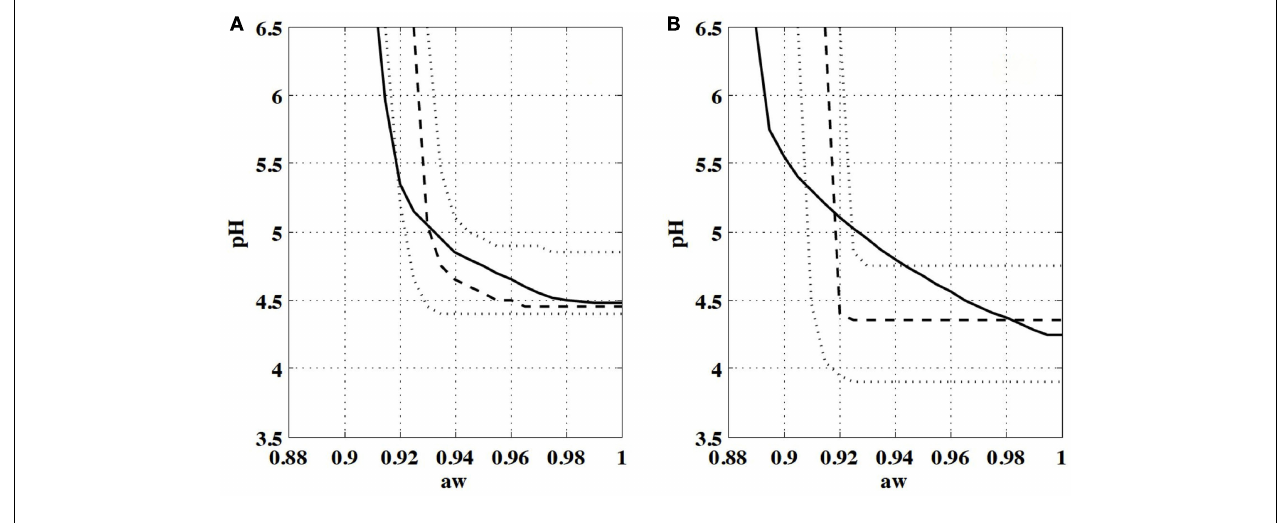
Koutsoumanis and Sofos (2005) for a growth probability of 0.5. Dashed and dotted lines are interfaces predicted with the model for a growth probability of 0.5. Dashed lines correspond to the median behavior and dotted lines represent the 2.5th and 97.5th percentiles of variation or